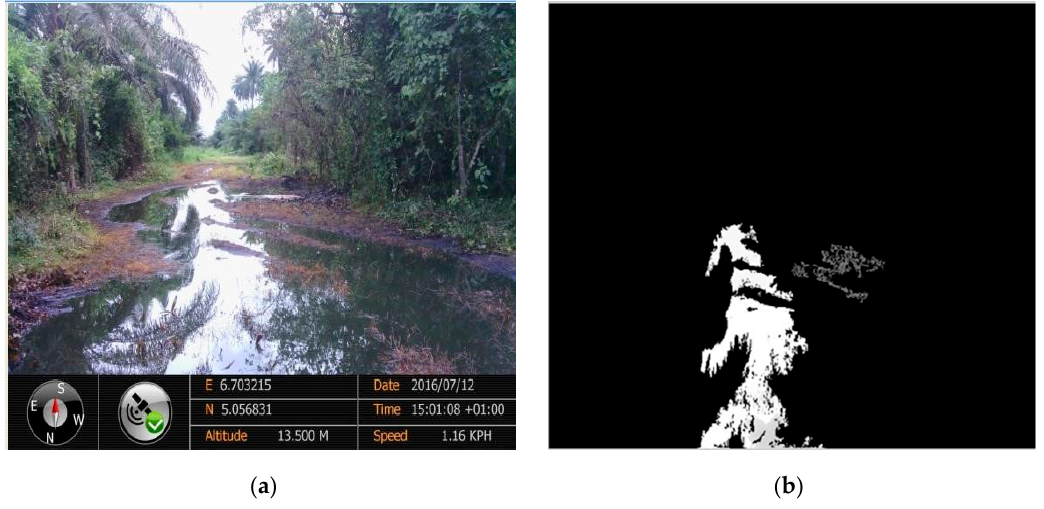
Figure 8. ( a ) Sample Image OS9; ( b ) Detected crude oil spill from OS9.